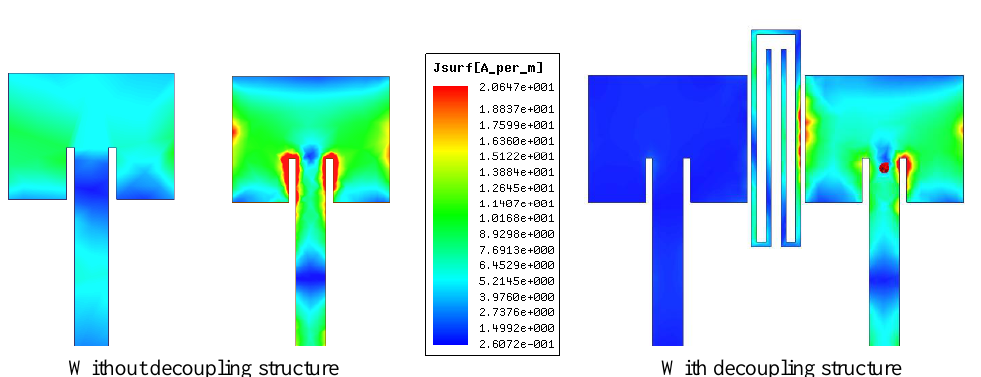
Figure 10. Surface current distribution of the antenna at 5.4 GHz in the presence and absence of decoupling structure.